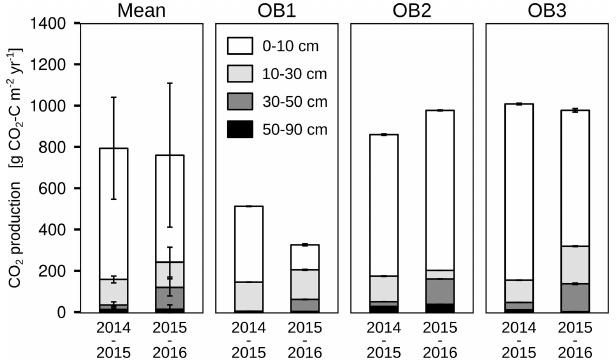
Figure 6. Cumulative CO 2 production for each soil layer, observa- tory (OB) and year of observation. Error bars represent the standard deviation.